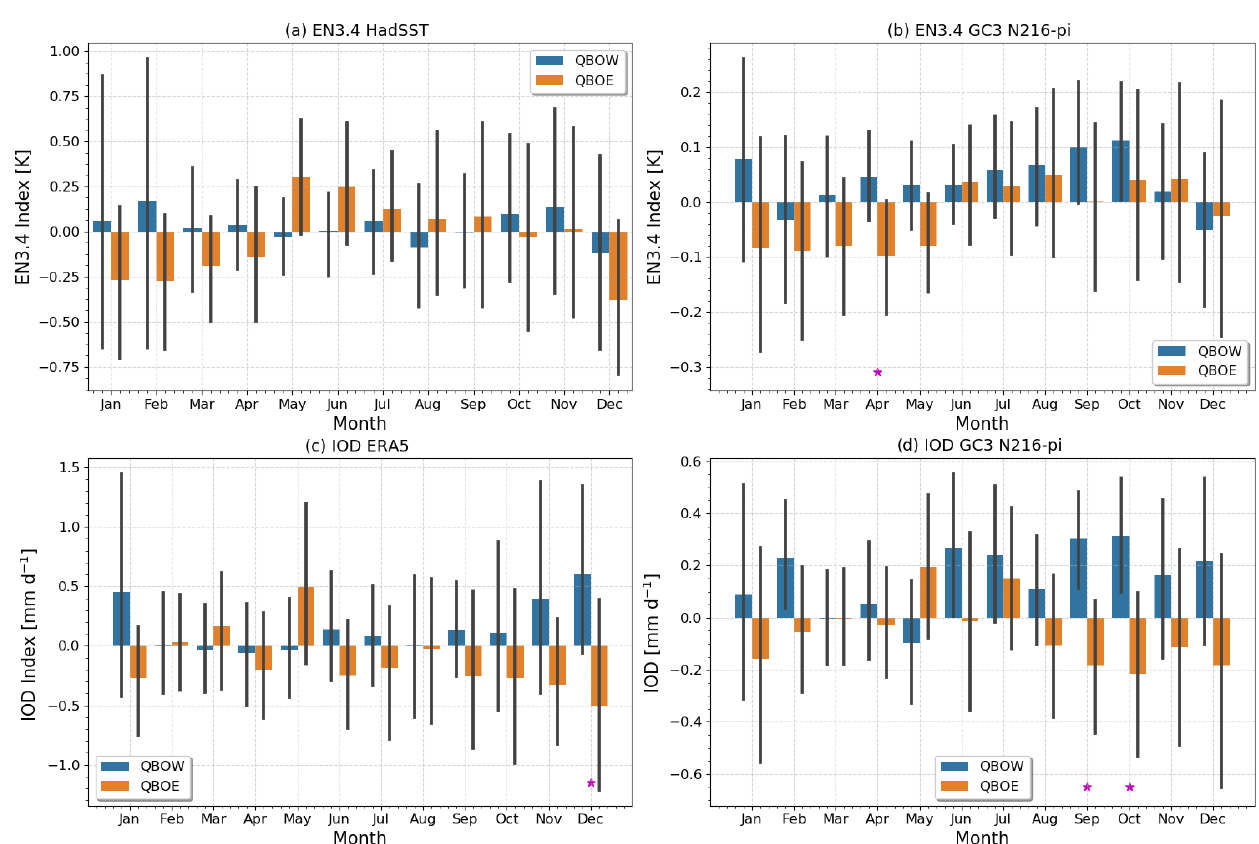
Figure 7. Monthly mean (a, b) EN3.4 and (c, d) IOD indices separated per QBO phase in (a, c) observations/reanalysis ERA5 and HadSST (1979–2021) and (b, d) GC3 N216-pi. The error bars show the standard deviation of each index for each month, and significant differences between QBOW and QBOE months are highlighted with a (cid:63) at the bottom of each